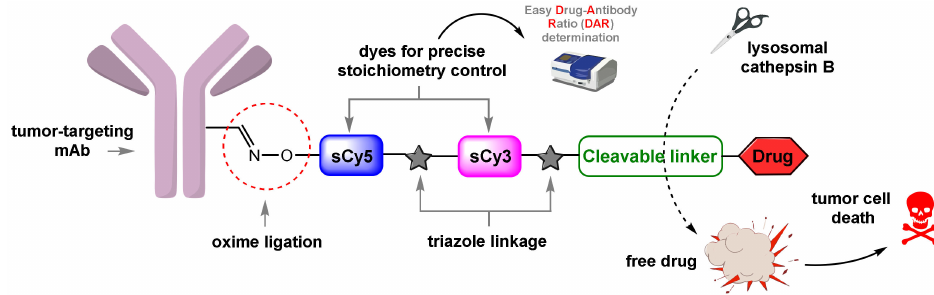
Figure 1. The methodology affords a site-specific ADC with facile stoichiometry